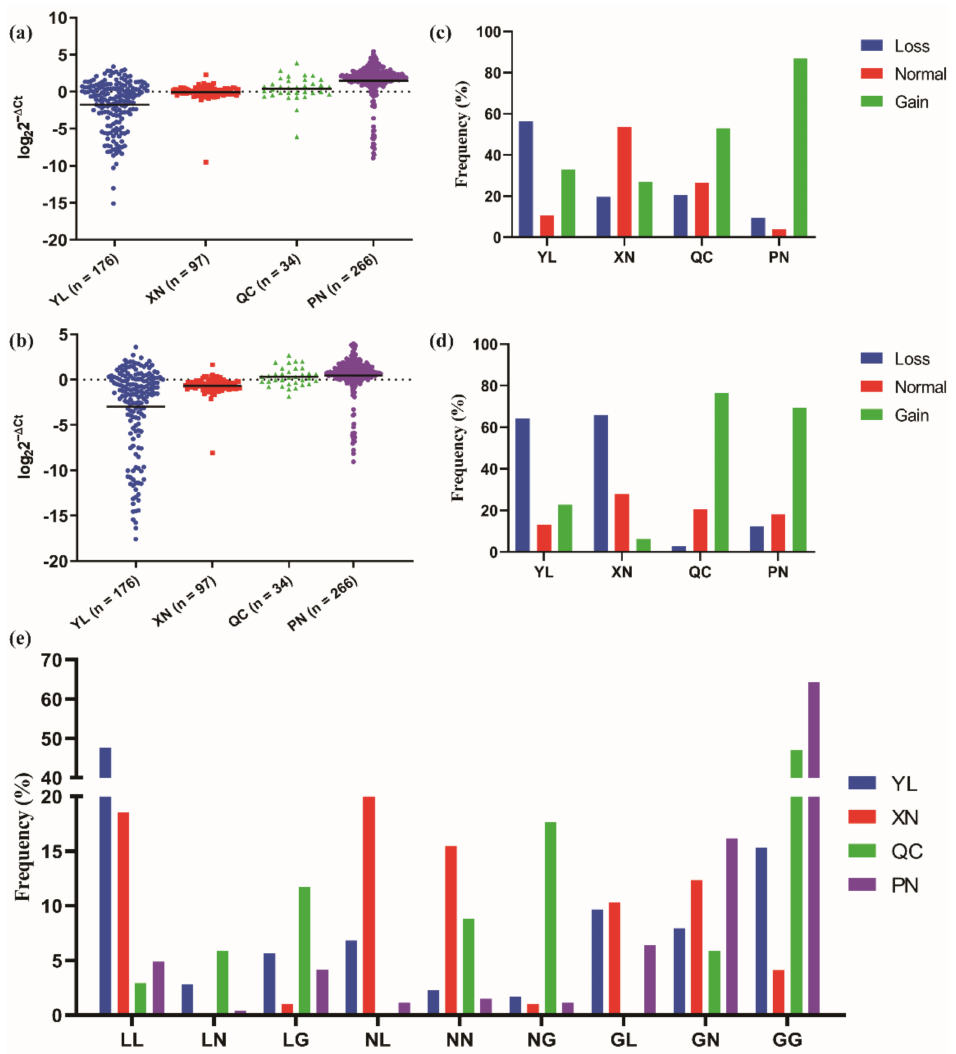
Figure 3. The distribution of the CLCN2 gene CNV1 and CNV2 and their combination in the different Chinese cattle breeds. ( a ) The distribution of CLCN2 gene CNV1 copy numbers in four Chinese cattle breeds. ( b ) The distribution of CLCN2 gene CNV2 copy numbers in four Chinese cattle